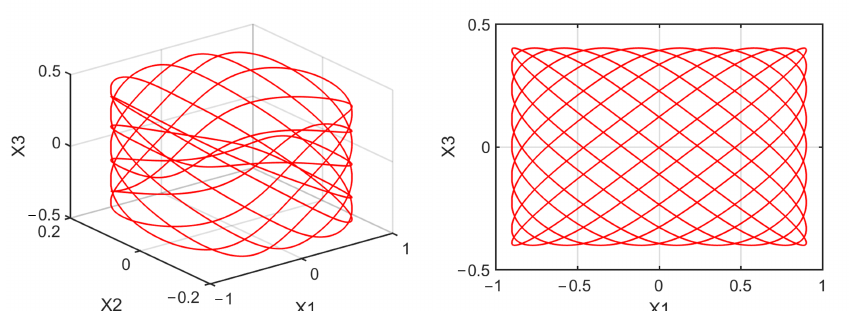
Figure A7. Periodic-9 motion of σ 2 = 5.1468.